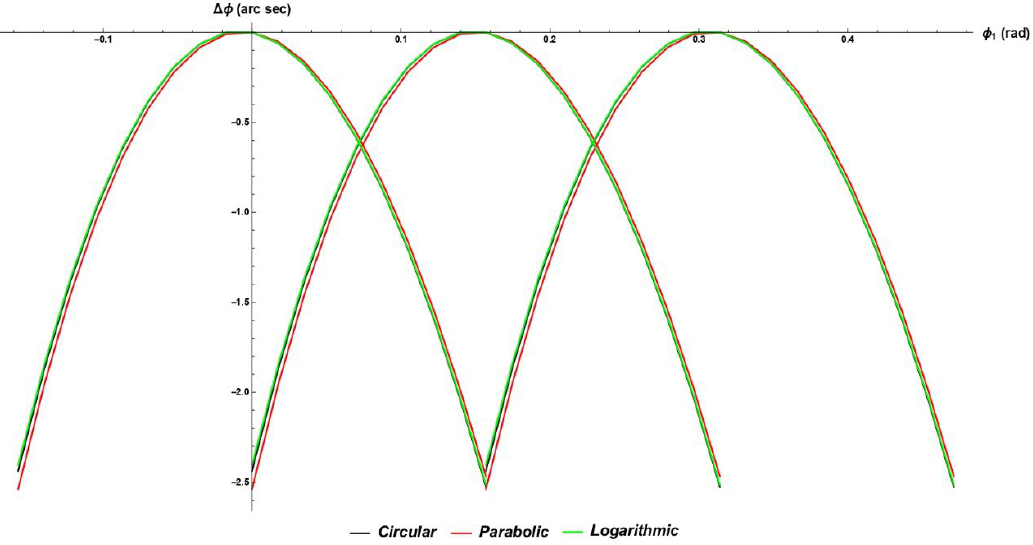
Figure 18. TE of helical gear with three types of modification and 0.2° (3.5 mrad) of in-plane angular misalignment.